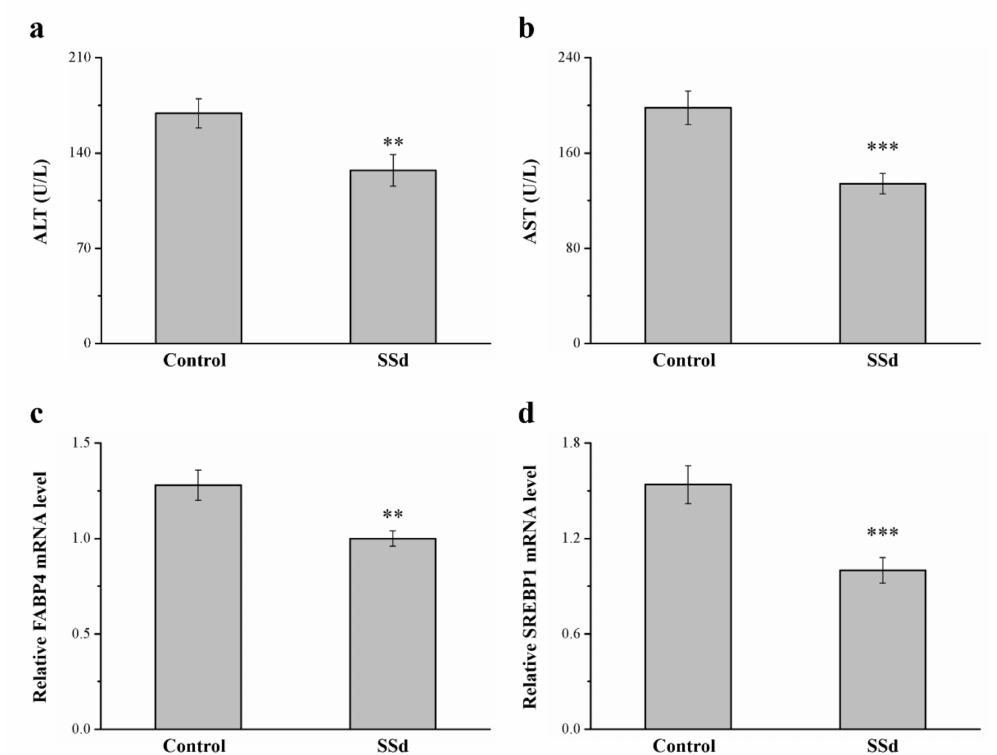
Figure 8. Effects of SSd on ( a ) serum ALT, ( b ) serum AST, and hepatic mRNA levels of ( c ) FABP4 and ( d ) SREBP1 measured in the control and SSd groups. All data are reported as means ± SD (n = 8). ** p < 0.01; *** p < 0.001. FABP4, fatty acid–binding protein 4; SREBP1, sterol regulatory element–binding protein